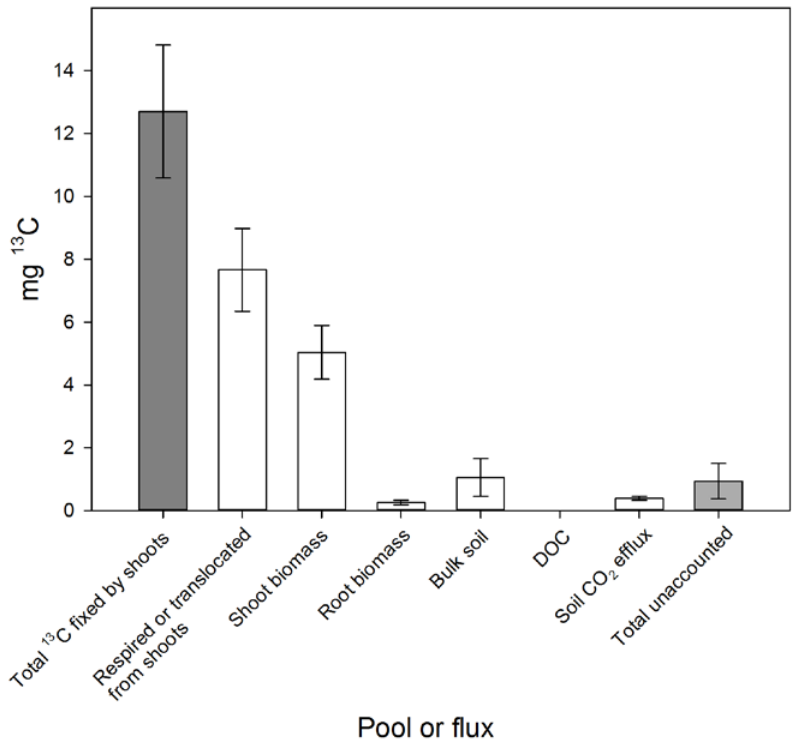
Figure 7. The amount of 13 C fixed by Calluna vulgaris shoots (dark grey) after exposure to atmospheric concentrations of ~ 99 atom % 13 CO 2 for four hours, its subsequent allocation into major pools and fluxes of C, and the mean amount of 13 C unaccounted for (light grey) in the following 20 days (means ±